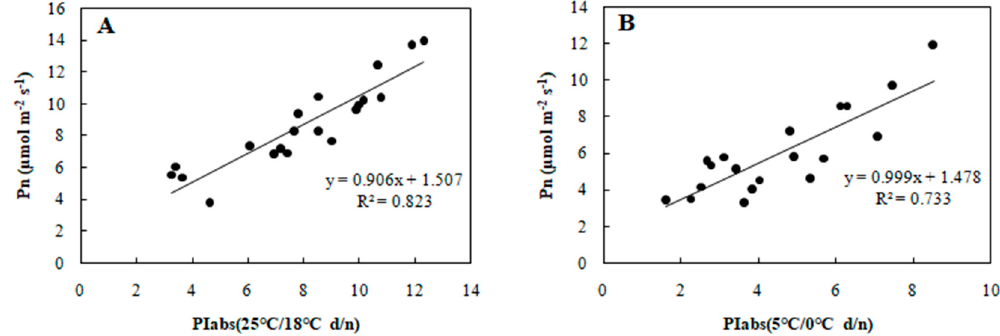
Figure 3. Correlation between PIabs and Pn in 20 wucai genotypes measured in ( A ) 25/18 ◦ C (d/n) treatment and ( B ) 5/0 ◦ C (d/n) treatment.